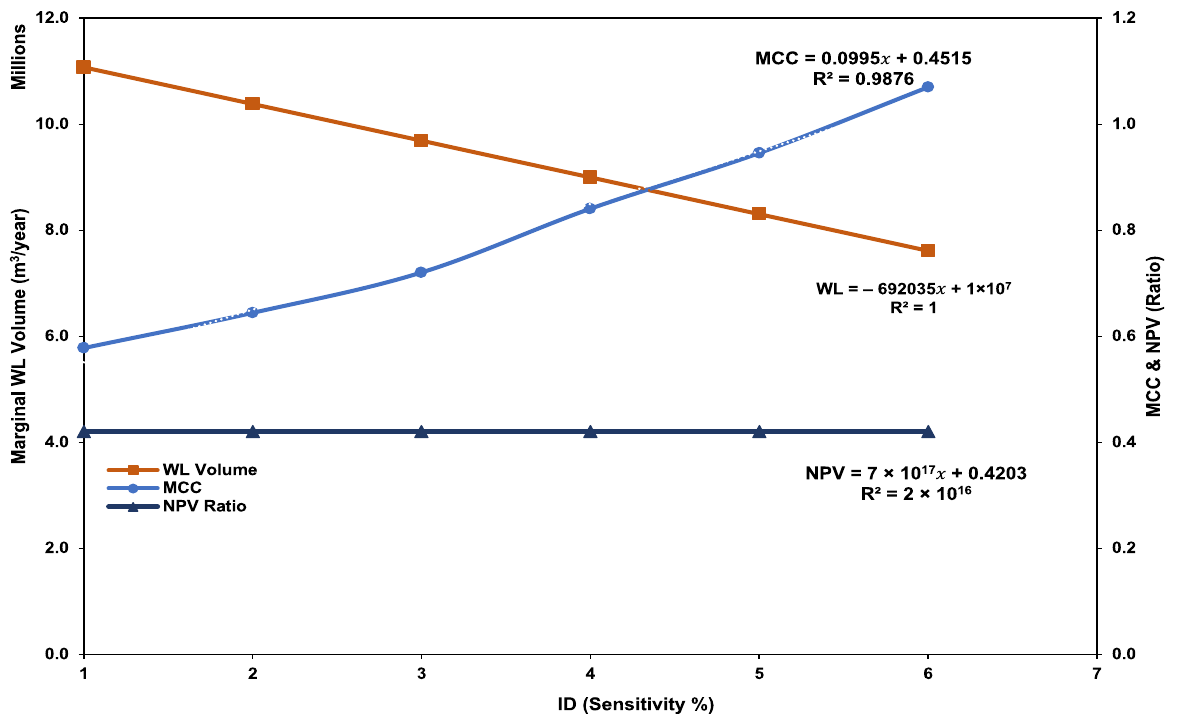
Figure 6. Operation and maintenance sensitivity analysis graph for marginal cost of capital (MCC) and net present value (NPV). WL: water loss.